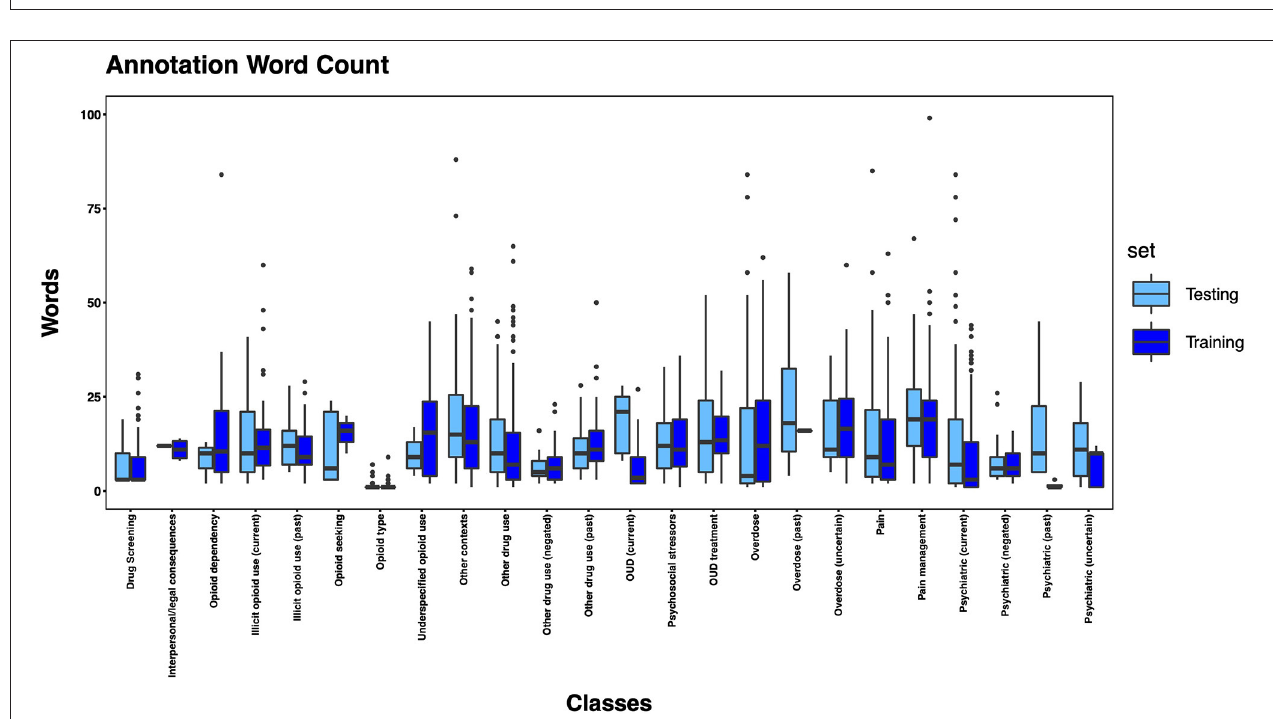
FIGURE 4 | Boxplot of the mean count of words per annotation, by class, comparing training and testing sets.